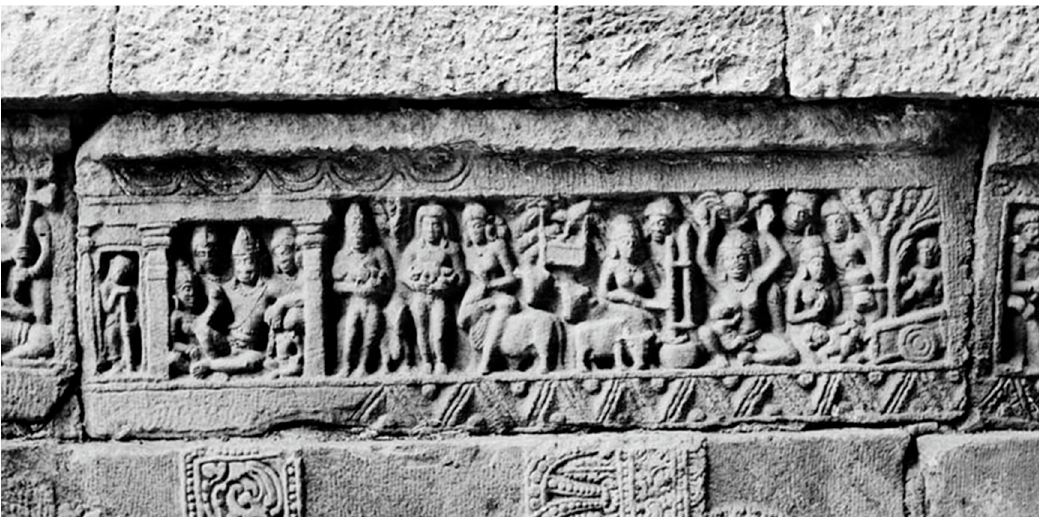
Figure 8. Exploits of the young K ṛṣṇ a: Churning without the “Butter-thief,” Arrival of K ṛṣṇ a at the Cowherd Village, the Goddess, Transfer of the Baby to the Cowherd Village/Killing of K ṛṣṇ a’s Sister, sixth–seventh century. Base of the southern side of the Upper Ś iv ā laya Temple, B ā d ā m ī , Karnataka.